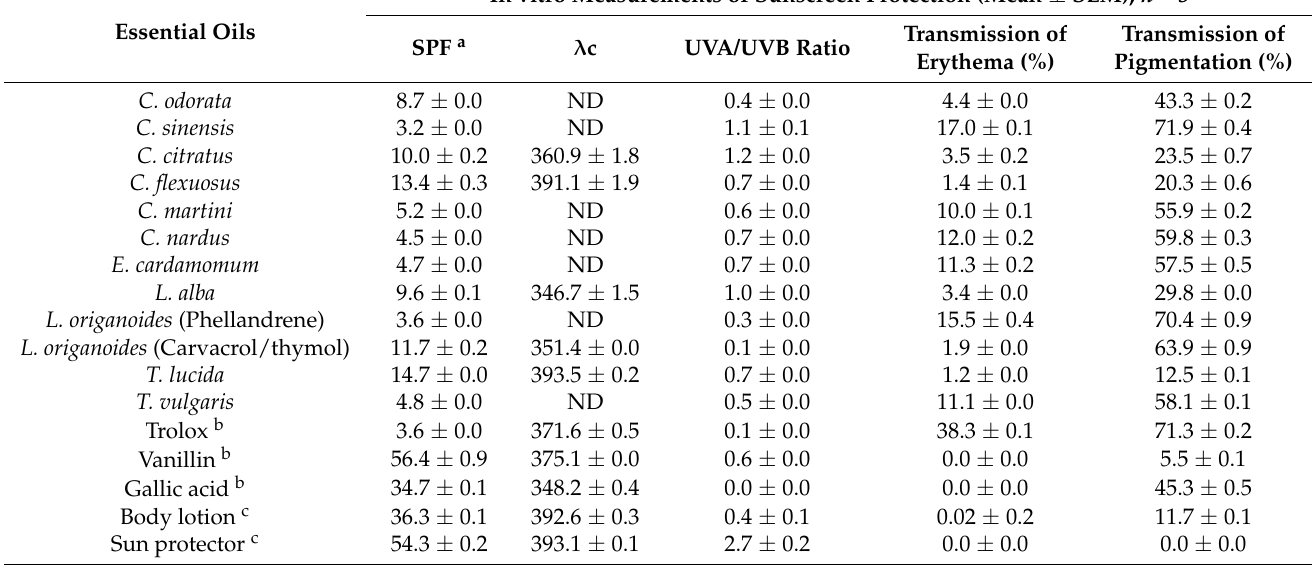
Table 2. In vitro assessment of UV protective properties of essential oils.